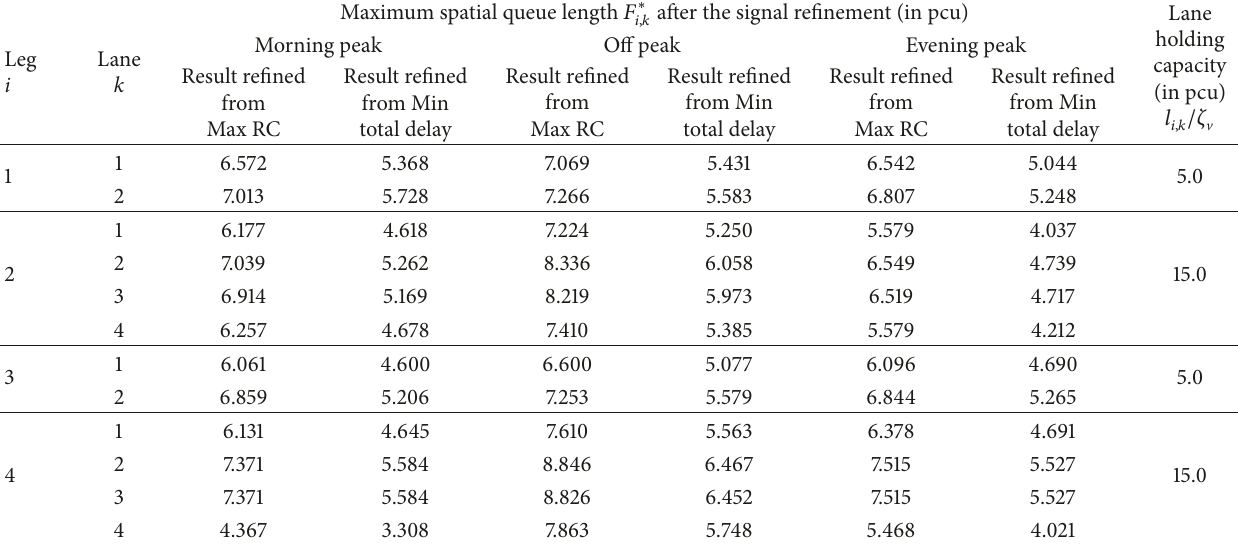
Table 3: Maximum queue length after traffic signal refinement at fixed cycle